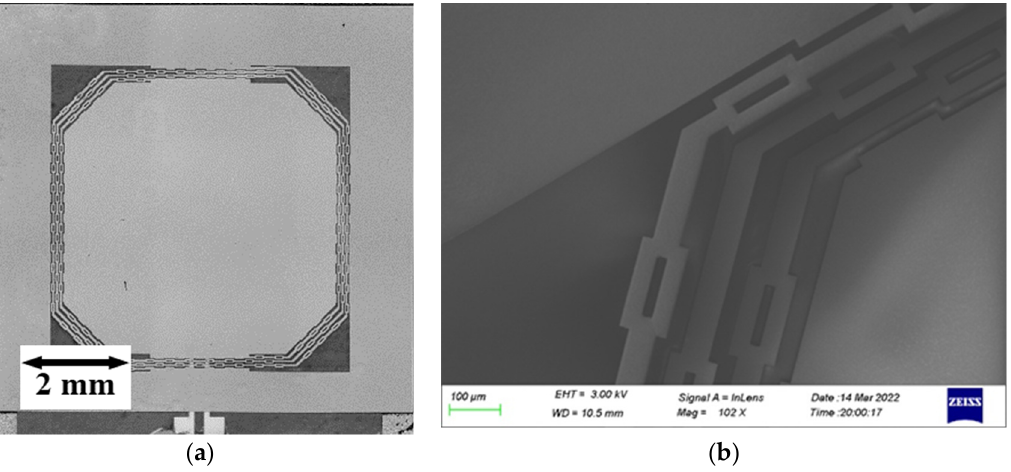
Figure 11. ( a ) Optical photograph of the resonant acceleration switch ; ( b ) SEM of the beams of the resonant acceleration switch.